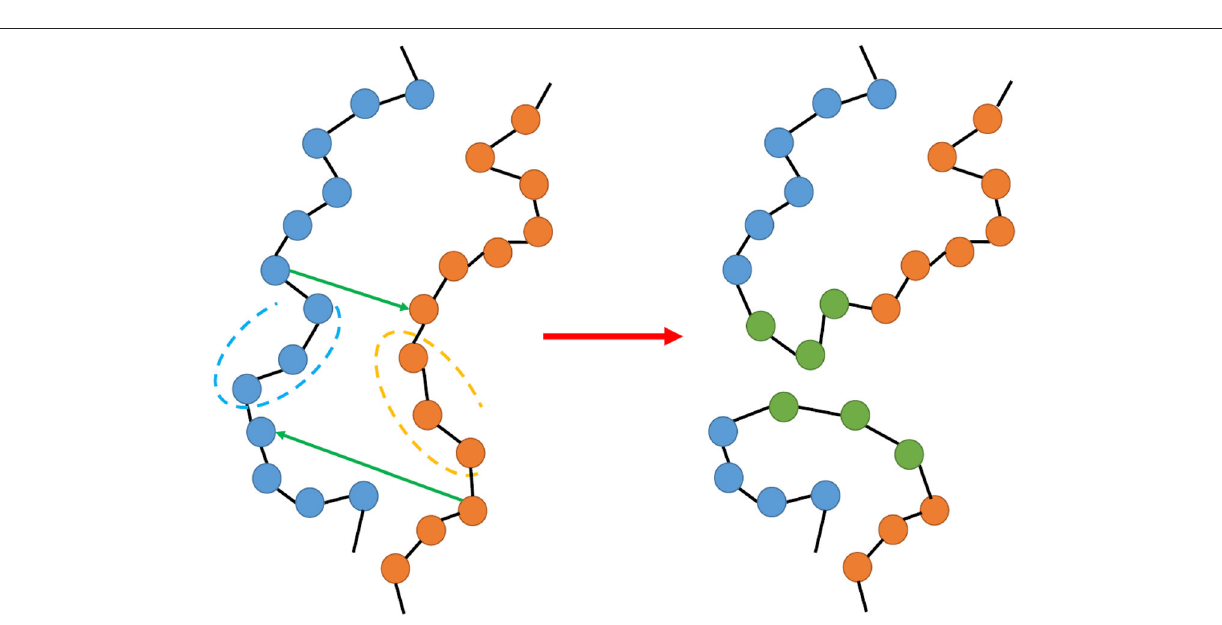
FIGURE 5 | Schematic illustration of the double bridging Monte Carlo move for polymer simulations in continuous space. In general, given an internal atom in one chain and an internal atom in the other chain, there are four possible combinations with which this move can be realized (based on what pairs of trimers are chosen to be cut out), and in the Figure we have included only one of these